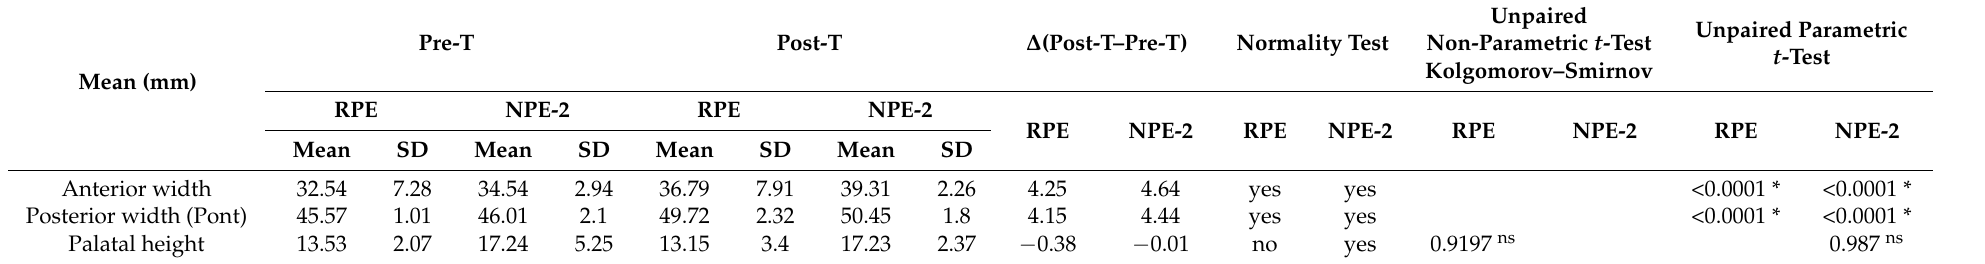
Table 1. Mean values of anterior width, posterior width (Pont’s landmarks), and palatal height before and after treatment in patients treated with RPE or NPE-2